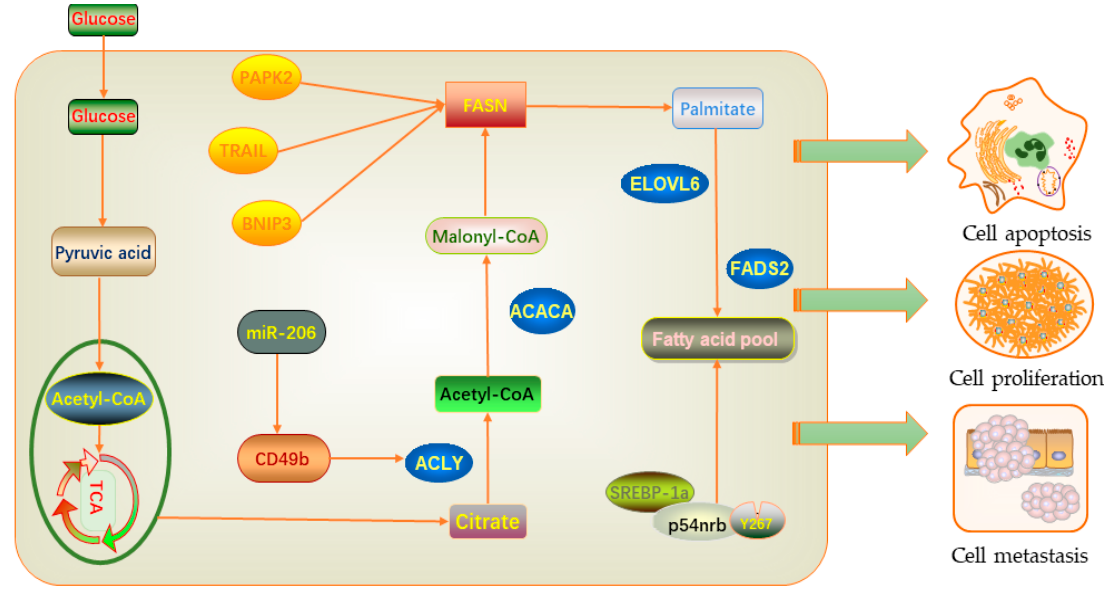
Figure 3. Lipid-related regulatory factors promoting the occurrence and development of breast cancer.